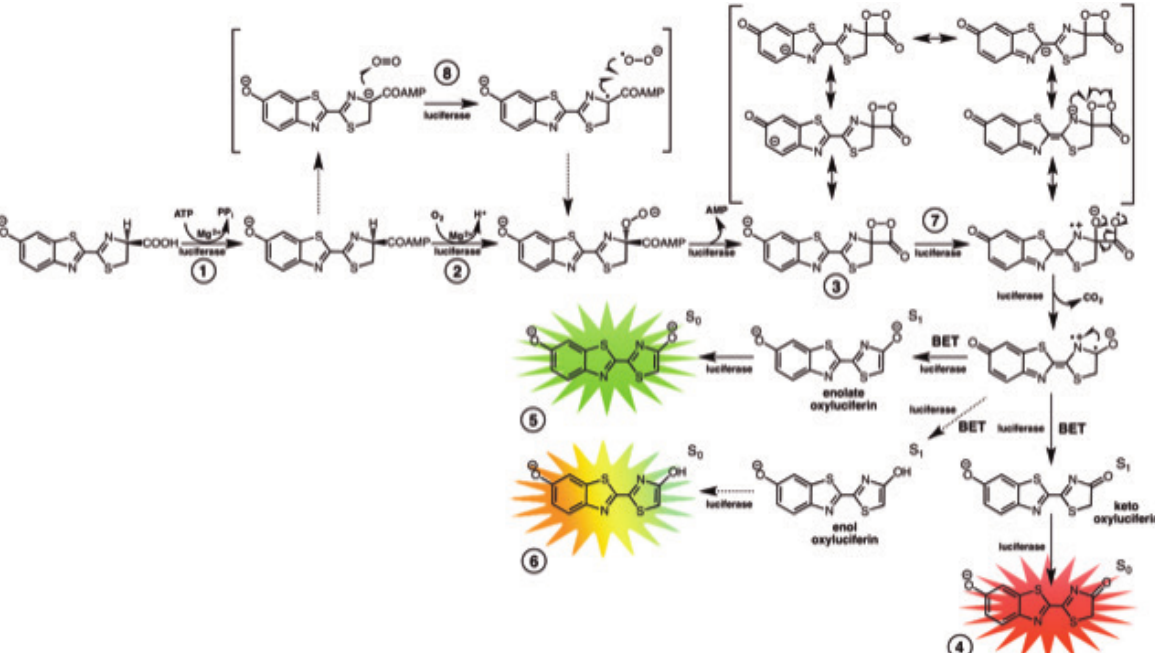
Figure 3 - Detailed mechanism of firefly luciferin oxidation and chemiexcitation catalyzed by luciferase. BET, back electron